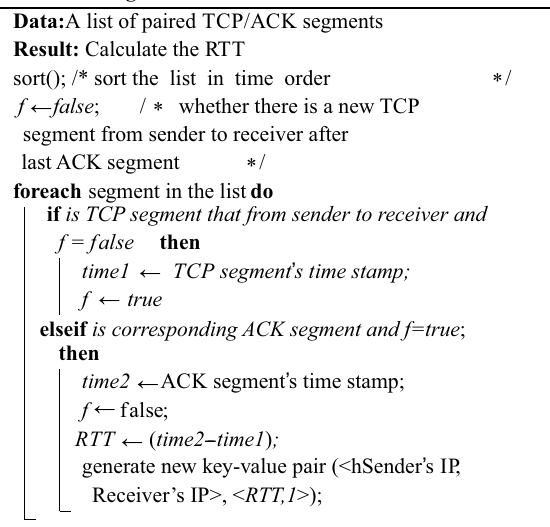
Algorithm 2: Calculate the RTTs from the list of paired TCP/ACK